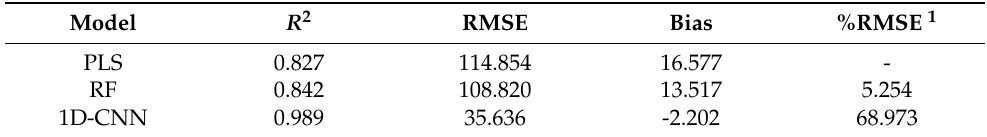
Table 3. Mean values of R 2 , RMSE, bias, and relative improvement (%RMSE) from 5-fold cross validation in the training dataset for developing the partial least squares (PLS), random forest (RF), and one dimensional convolutional neural network (1D-CNN)